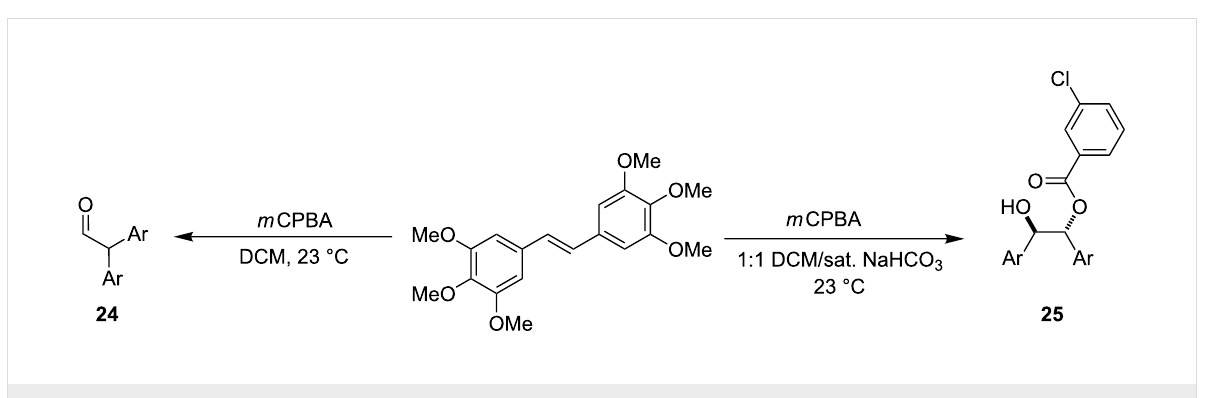
Scheme 2: m CPBA epoxidation of electron-rich stilbene